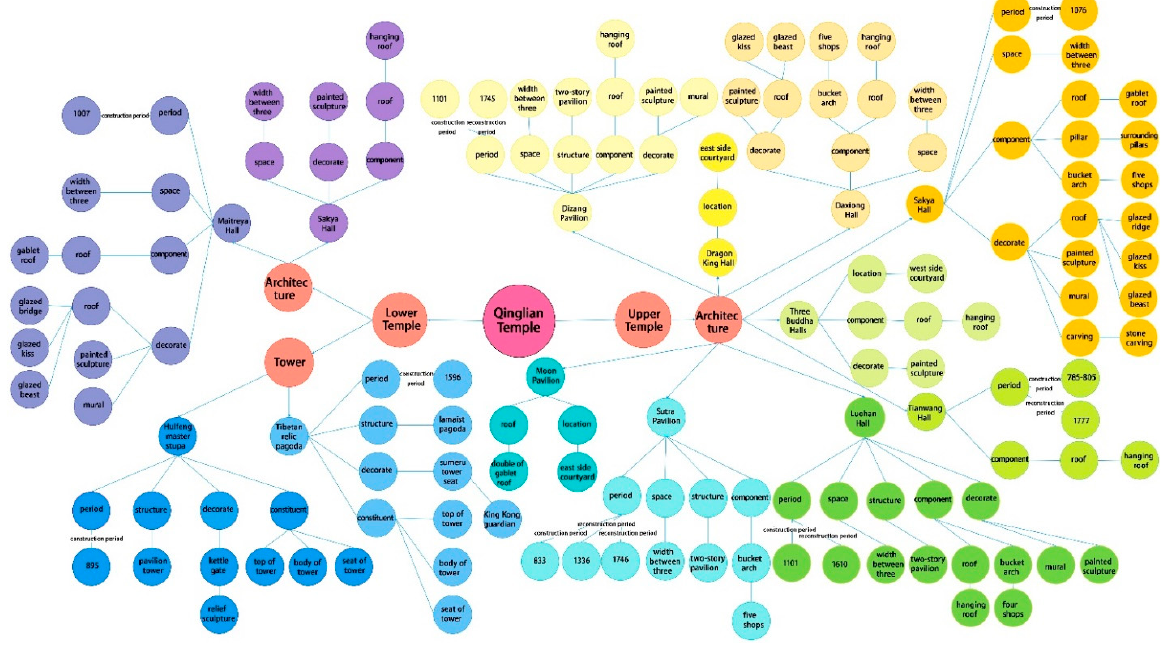
Figure 13. Knowledge graph of Qinglian Temple.